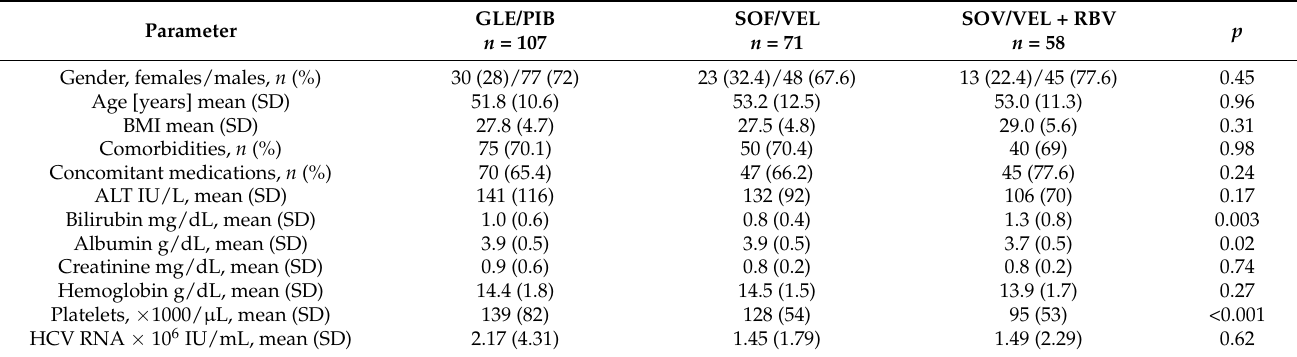
GLE/PIB SOF/VEL n = 107 n = 71